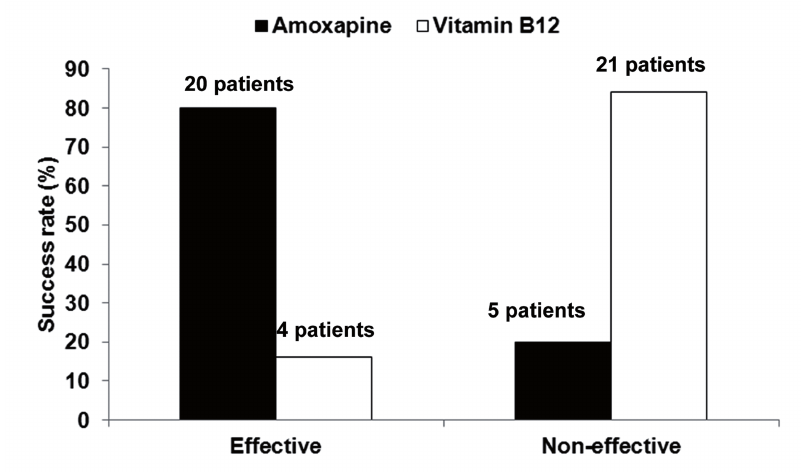
. fisher’s exact test, P < 12